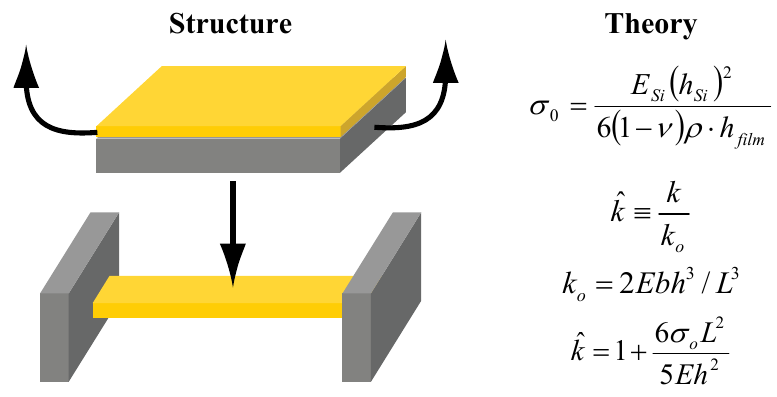
Figure 9. Illustration of common mechanical characterization methods to measure residual stress. In the beam residual stress calculation, k ˆ is the ratio of measured beam stiffness k to , E is beam elastic modulus, b is beam width, h is beam theoretical beam stiffness k 0 thickness, L is beam length, and σ is the beam residual stress. For blanket film residual 0 is elastic modulus of silicon wafer, h is silicon wafer thickness, υ is stress calculation, E Si Si Poisson’s ratio of silicon wafer, ρ is measured radius of curvature of silicon wafer, and h film is the film